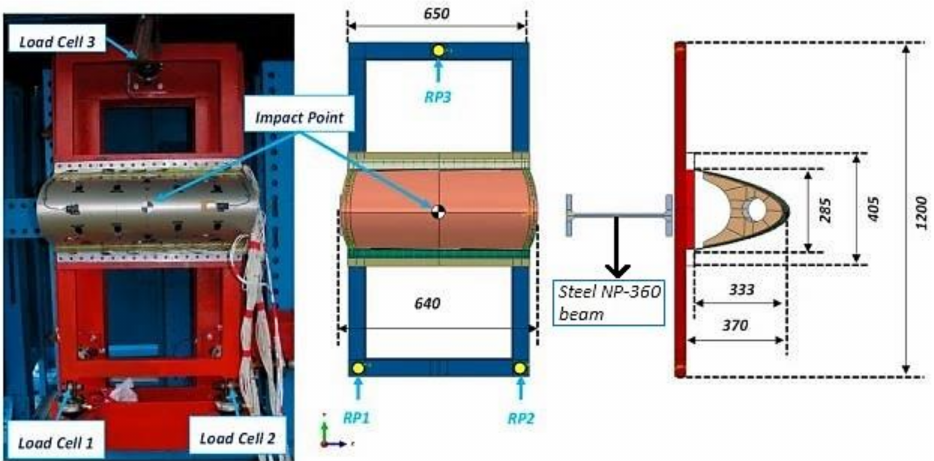
Figure 1. Experimental and Numerical Model according to the literature. Reprinted with permission from Refs. [25,34]. 2020 [25] and 2019 [34], Di Caprio et